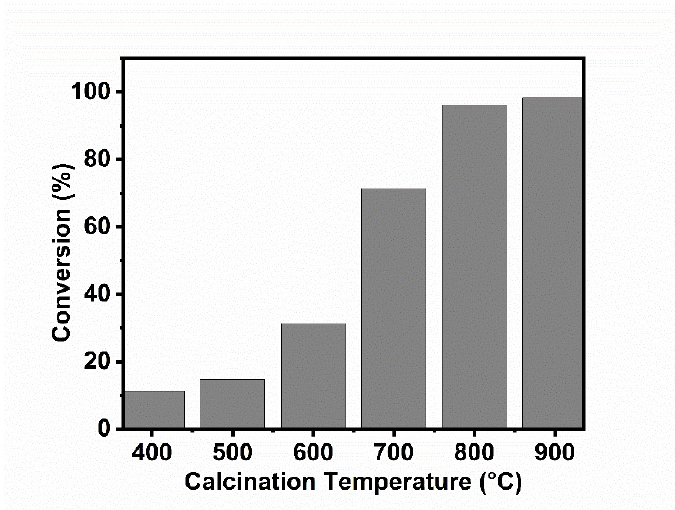
Figure 10. Effect of the catalyst (parent shell) calcination temperature on the biodiesel production using refined oil.